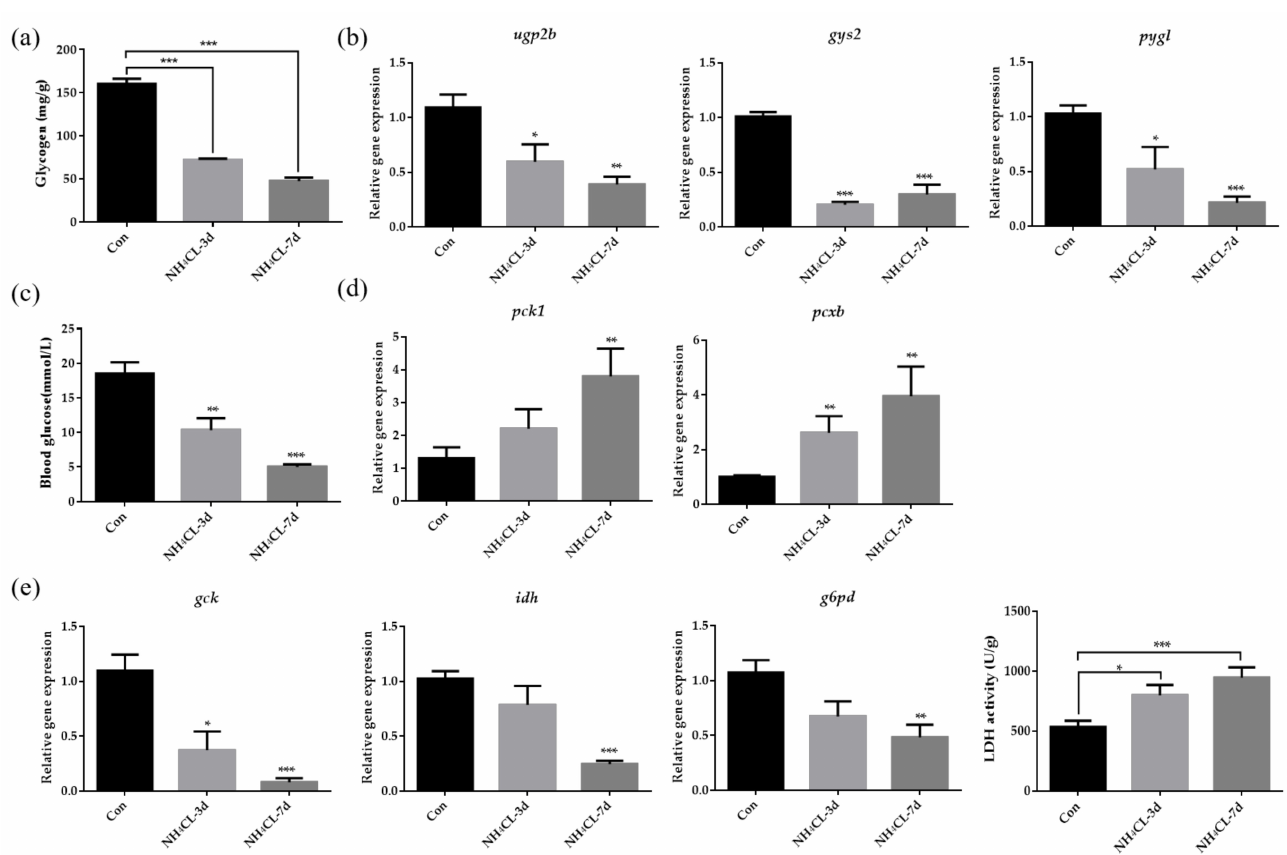
Figure 3. The carbohydrate metabolism in largemouth bass liver after ammonia exposure for 3 days and 7 days was affected. ( a ) Glycogen content in largemouth bass liver. ( b ) The relative expression of genes involved in glycogen metabolism ( ugp2b , gys2 , pygl ) in largemouth bass liver. ( c ) Glucose levels in largemouth bass serum. ( d ) The relative expression of gluconeogenesis-related gene ( pck1 , pcxb ) in largemouth bass liver. ( e ) The relative expression of genes related to glucose metabolism ( gck , idh , g6pd ) in largemouth bass liver. Enzyme activity of lactate dehydrogenase activity in largemouth bass liver. All data were analyzed with Student’s t -test and data were mean ± SEM ( n = 6). * p < 0.05; ** p < 0.01; *** p <